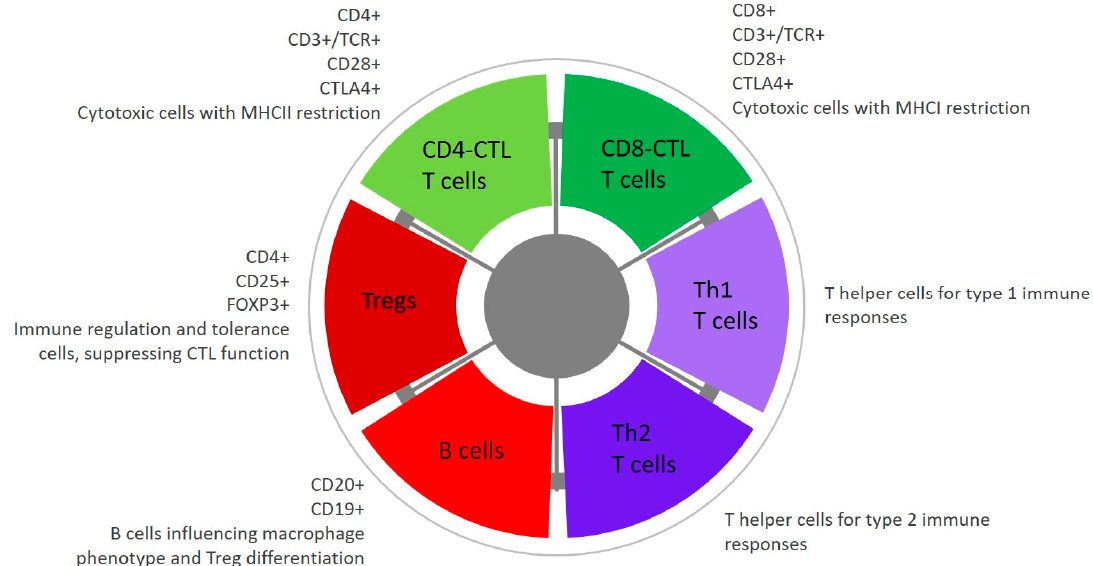
Figure 2. Subtypes of lymphocytes involved in immune responses to melanoma cells. Neoplastic cells are killed by cytotoxic T lymphocytes (CTLs), with anti-cancer responses supported by T helper (Th) cells. Immunosupressive and pro-tumour roles are ascribed to T regulatory cells (Tregs) and a subtype of B lymphocytes.